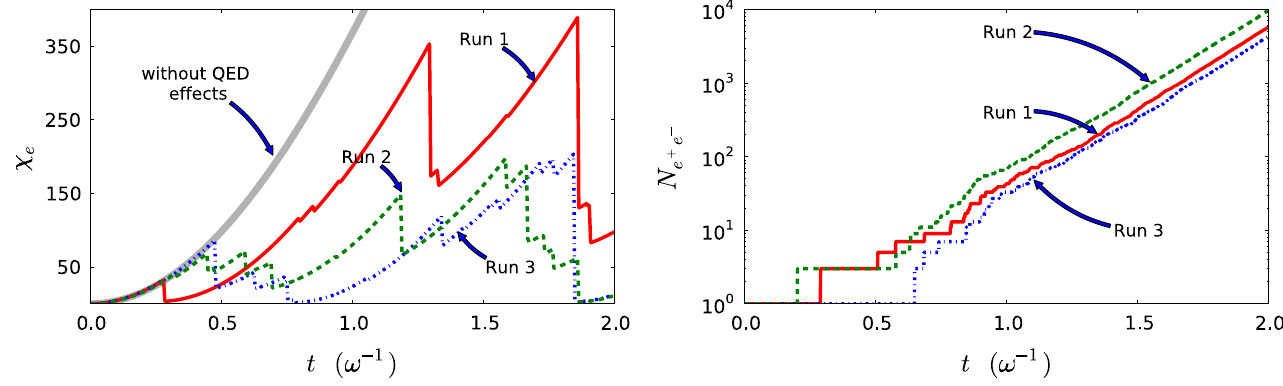
FIG. 4. Left plot: Temporal evolution of the quantum dynamical parameter (cid:5) e of the primary electron for three independent Monte- Carlo simulations. The thick gray curve corresponds to the analytical solution Eq. (9b) for (cid:5) e ð t Þ in the absence of any QED processes. The three other curves (run 1, run 2, and run 3) are the results of the three independent Monte-Carlo simulations with parameters 2 (cid:1) 10 4 and @ ! ¼ 1 eV . Right plot: The total number of electrons and positrons N a 0 ¼ simulations.